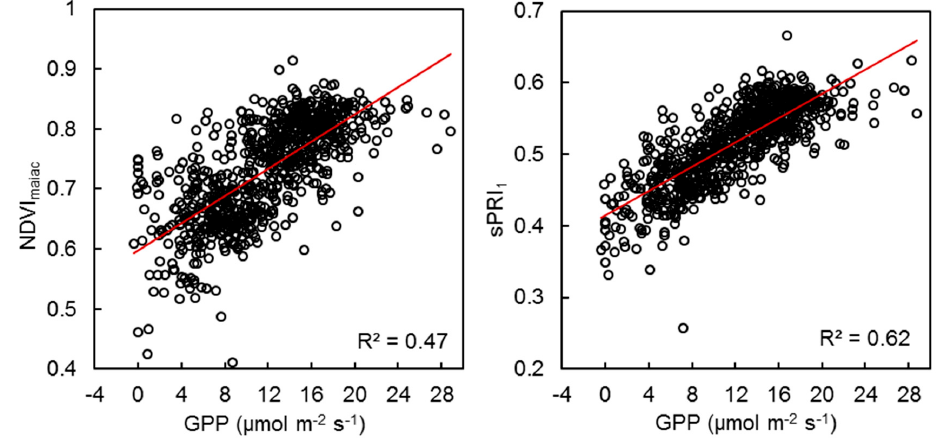
Figure 7. The relationship between NDVI maiac and sPRI 1 and flux tower measured gross primary productivity (GPP). The red lines are simple linear regression lines.